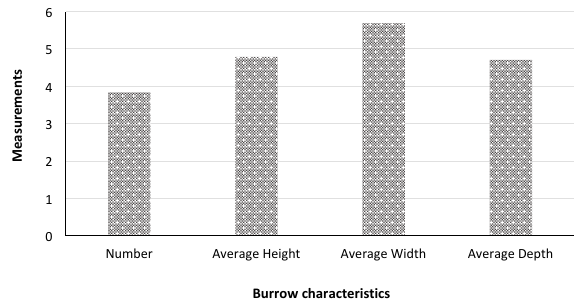
Figure 2. Average parameters of feeding burrows (cm) of the Indian Pangolin Manis crassicaudata recorded at two selected sampling sites of the Mansehra District.